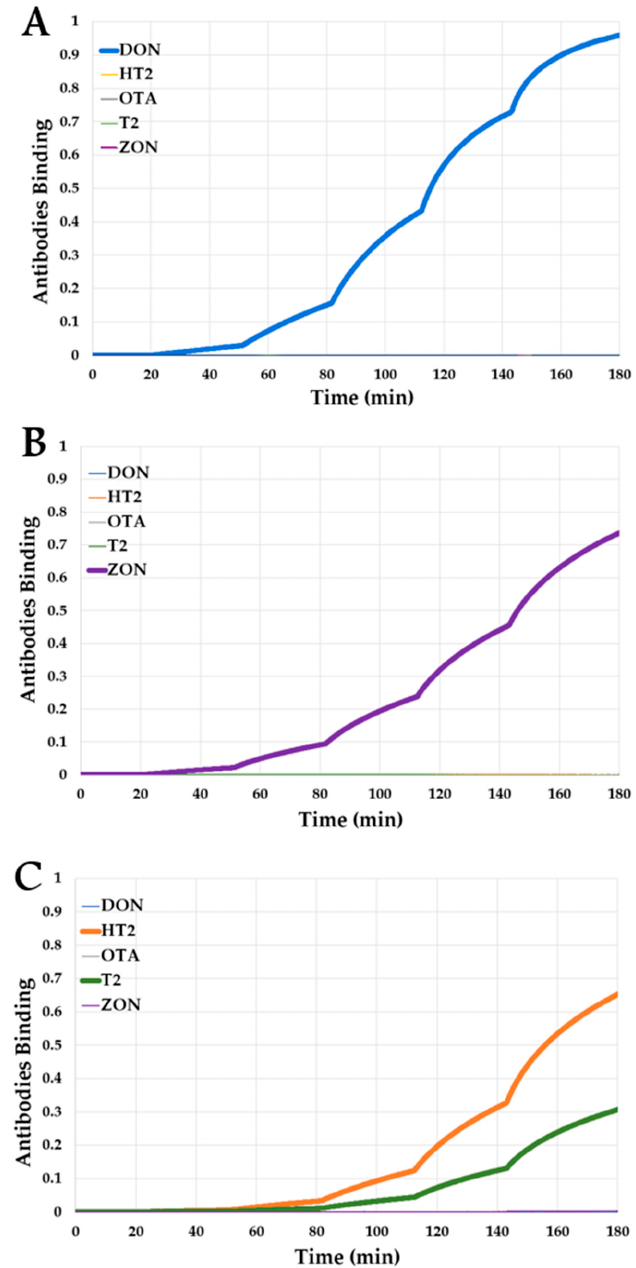
Figure 3. Characterization assay for the determination of kinetic parameters and cross-reactivity of monoclonal antibodies anti-deoxynivalenol ( A ), anti-zearalenone ( B ), and anti-T-2/HT-2 toxins ( C ).